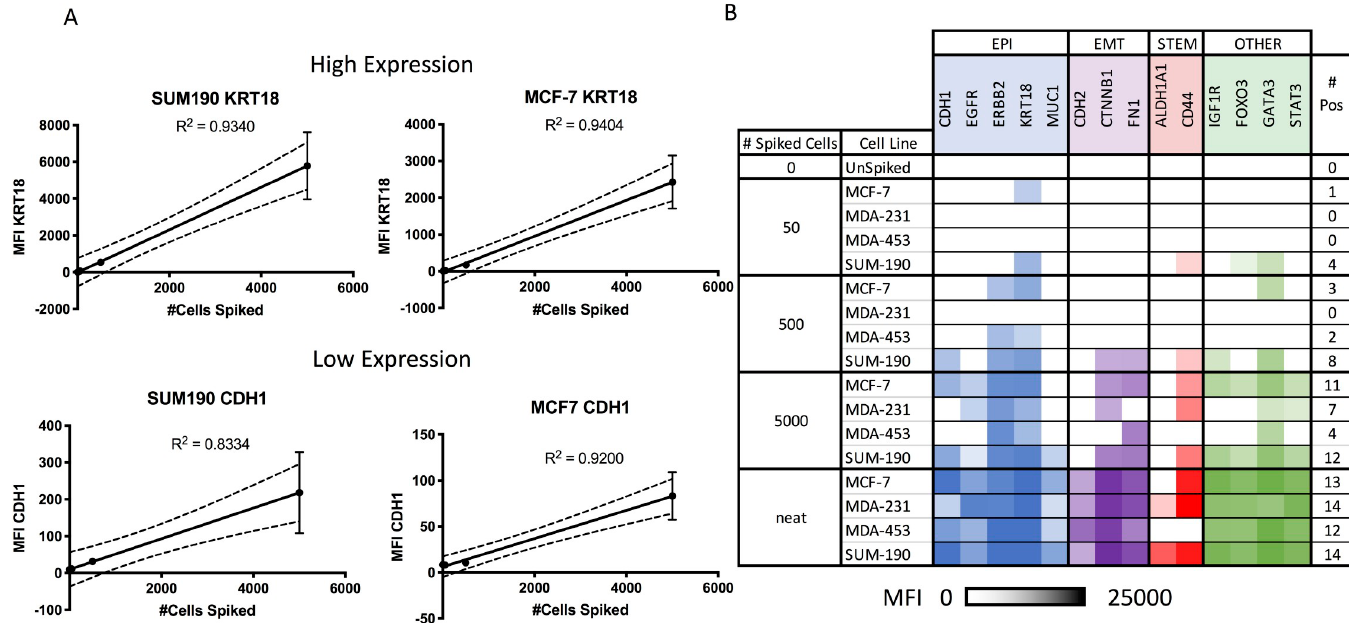
Fig 2. Linearity and sensitivity of QuantiGene branched DNA gene expression without amplification after Parsortix PR1 enrichment. Cells of the specified cell line were spiked into healthy donor blood, enriched by Parsortix PR1 system, and lysed. One quarter of the lysate from each sample was hybridized in duplicate. Gene expression of neat cultured cells, not spiked into blood, were used as controls. A) Linearity: Expression levels correlated well with the number of cells spiked into healthy donor blood, and this correlation was maintained (R 2 > 0.9) for most of the 25 genes tested. Representative data from tests of 2 genes (low and high expression) in 2 cell lines are shown. B) Sensitivity: KRT18 gene transcripts were detected in healthy donor blood spiked with as few as 50 SUM-190 cells or MCF-7 cells. Several gene transcripts were detected when > 50 cells were spiked. MDA-MB-453 gene transcripts were detected only in cell spikes of 500 cells or higher. Gene transcripts were detected in the partially mesenchymal cell line MDA-MB-231 only when several thousand cells were spiked. Numbers of cells spiked are specified here (the numbers of cells captured and therefore subjected to expression analysis will be lower). The gene expression from neat cells represents about 8000 cultured cells per assay well. Heat map shows natural log transformed expression after subtraction of the sham-spiked HDB (mean fluorescence intensity [MFI]) above the mean+ 1 standard deviation of un-spiked, enriched samples.